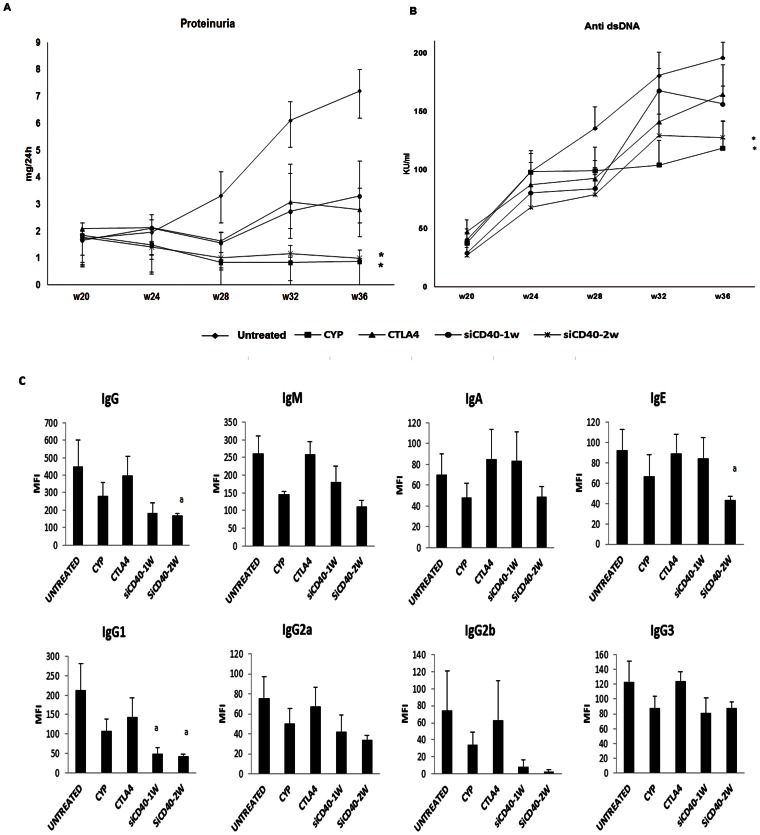
Proteinuria, anti dsDNA antibodies and Immunoglobulin isotype.A) 24 h-Proteinuria increased progressively in non treated mice to levels of heavy proteinuria. Treatment with CYP or siRNA anti CD40 twice per week induced a progressive reduction of proteinuria to levels almost physiological. B) Anti dsDNA antibodies increased progressively in non treated mice; siRNA anti CD40 twice per week reduced this production more effectively than CTLA4 or siCD40-1w group. C) Circulating immunoglobulin subclasses characterization. CD40 blockade with Chol-siRNA reduced total IgG and all IgG fractions. Data are expressed as mean±SEM of four separate experiments, p<0.05 a vs untreated.